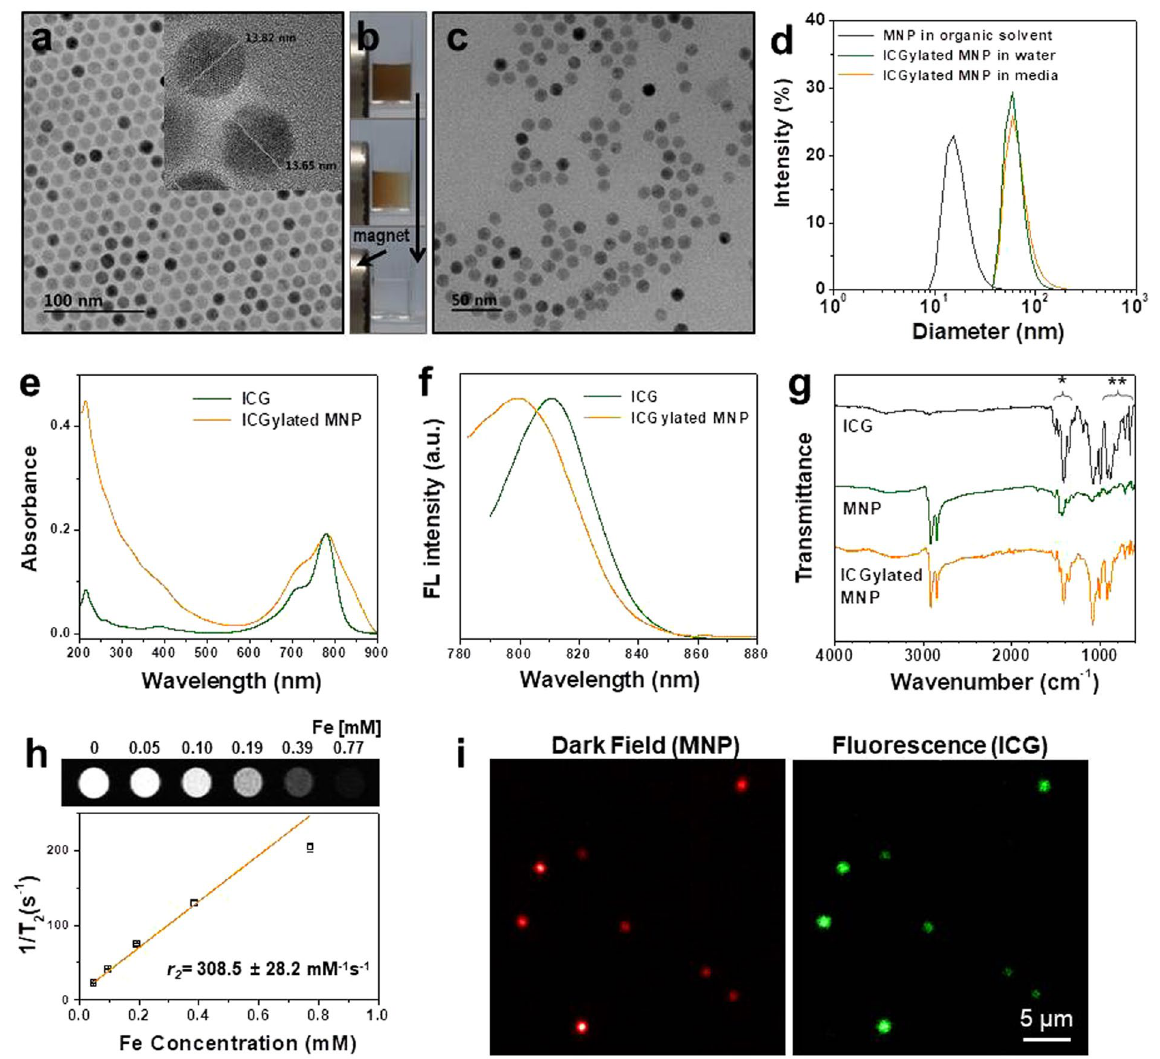
Figure 2. Characterization of ICGylated MNPs. ( a ) Transmission electron microscopy (TEM) image of MNPs in an organic solvent. ( b ) Magnetic separation procedure of ICGylated MNPs. ( c ) TEM image of ICGylated MNPs in water. ( d ) Size distribution of MNPs in an organic solvent and ICGylated MNPs in aqueous solvents. ( e ) Absorption and ( f ) fluorescence (emission scan at λ ex = 765 nm) spectra of ICG and ICGylated MNPs. ( g ) FT-IR spectra of MNPs, ICG, and ICGylated MNPs ( * aromatic C = C stretches, ** C-H out of plane bending). ( h ) T 2 relaxation rate (bottom, 1/ T 2 , s − 1 ) and T 2 -weighted MR images (top) as a function of Fe concentration for ICGylated MNPs. ( i ) Dark-field (left) and fluorescence microscopy (right) images of ICGylated MNPs at a single-particle level. MNPs are shown in the dark-field image; ICG is shown in the fluorescence